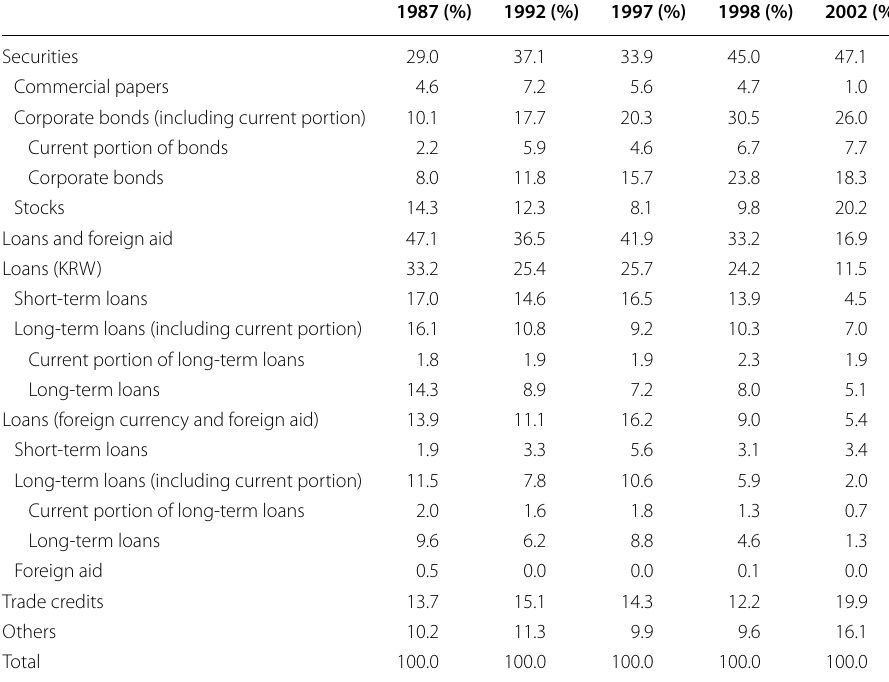
Table 3 Liabilities of the chaebo l (in